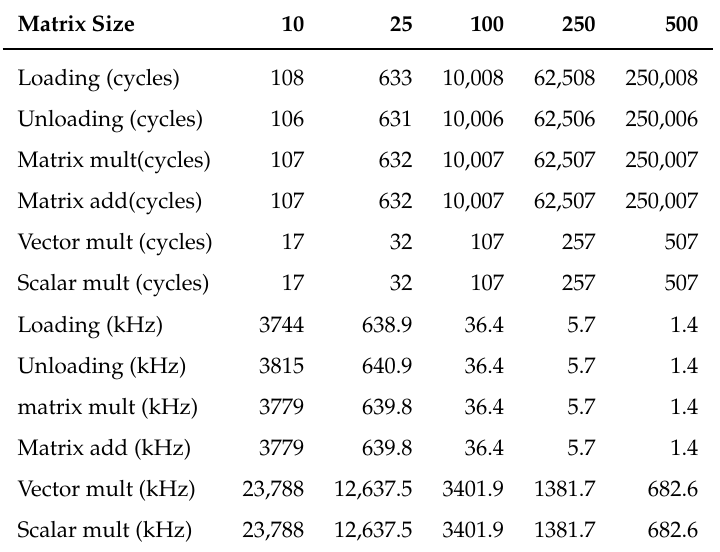
Table 4. Number of clock cycles and peak clock speed for different operations allowed by the computation